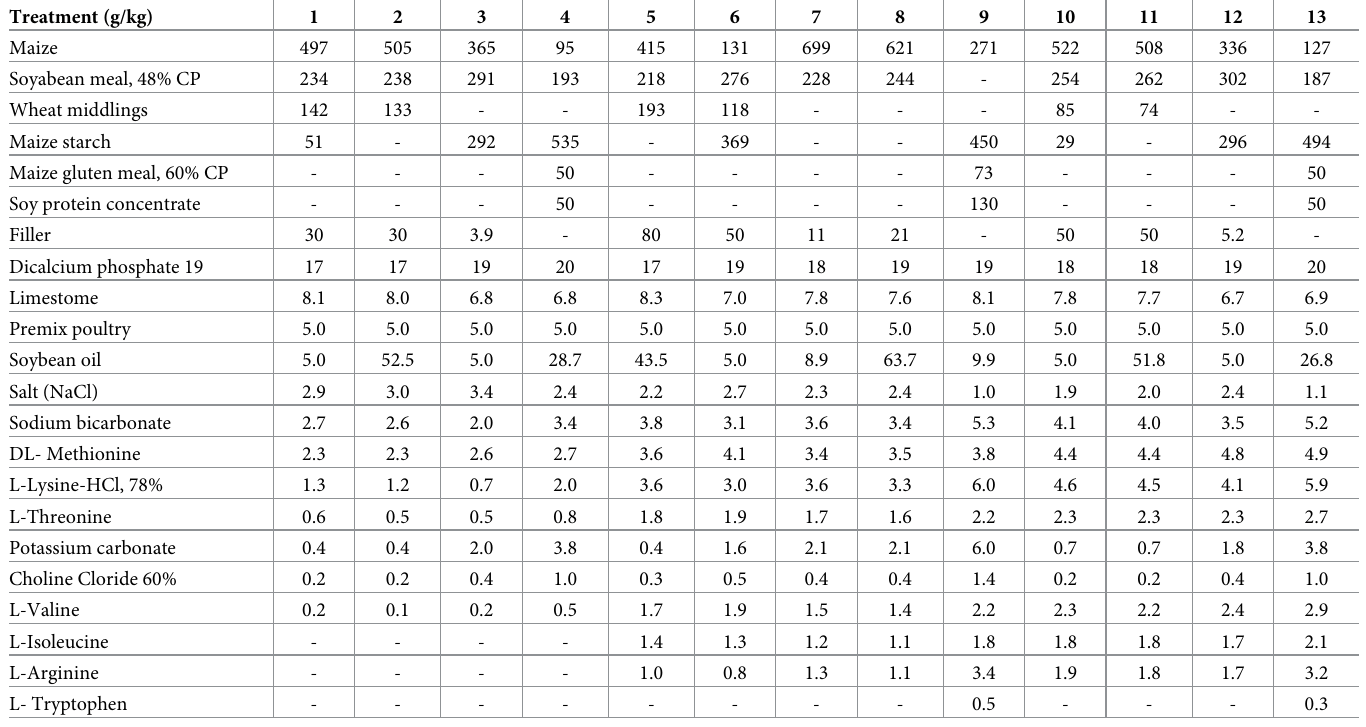
Table 3. Dietary formulations in experimental diets for broiler chickens from 21–35 days